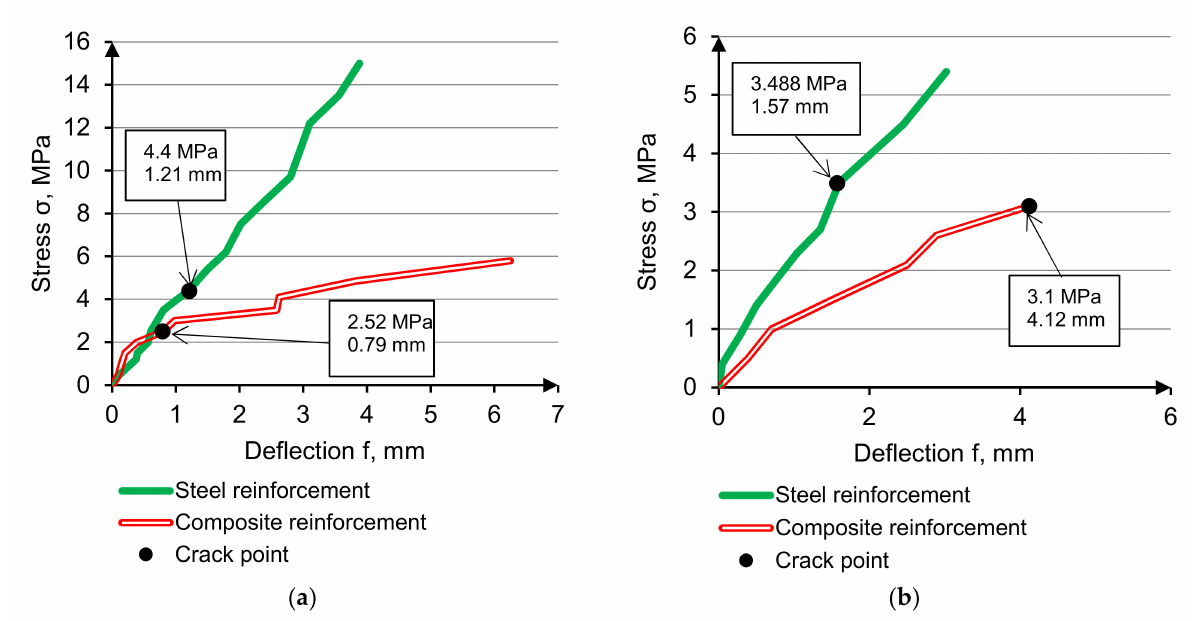
Figure 12. Stress-deflection curves for LWC D1600 concrete 3 ( a ), D1000 concrete 4 ( b ), reinforced by steel and